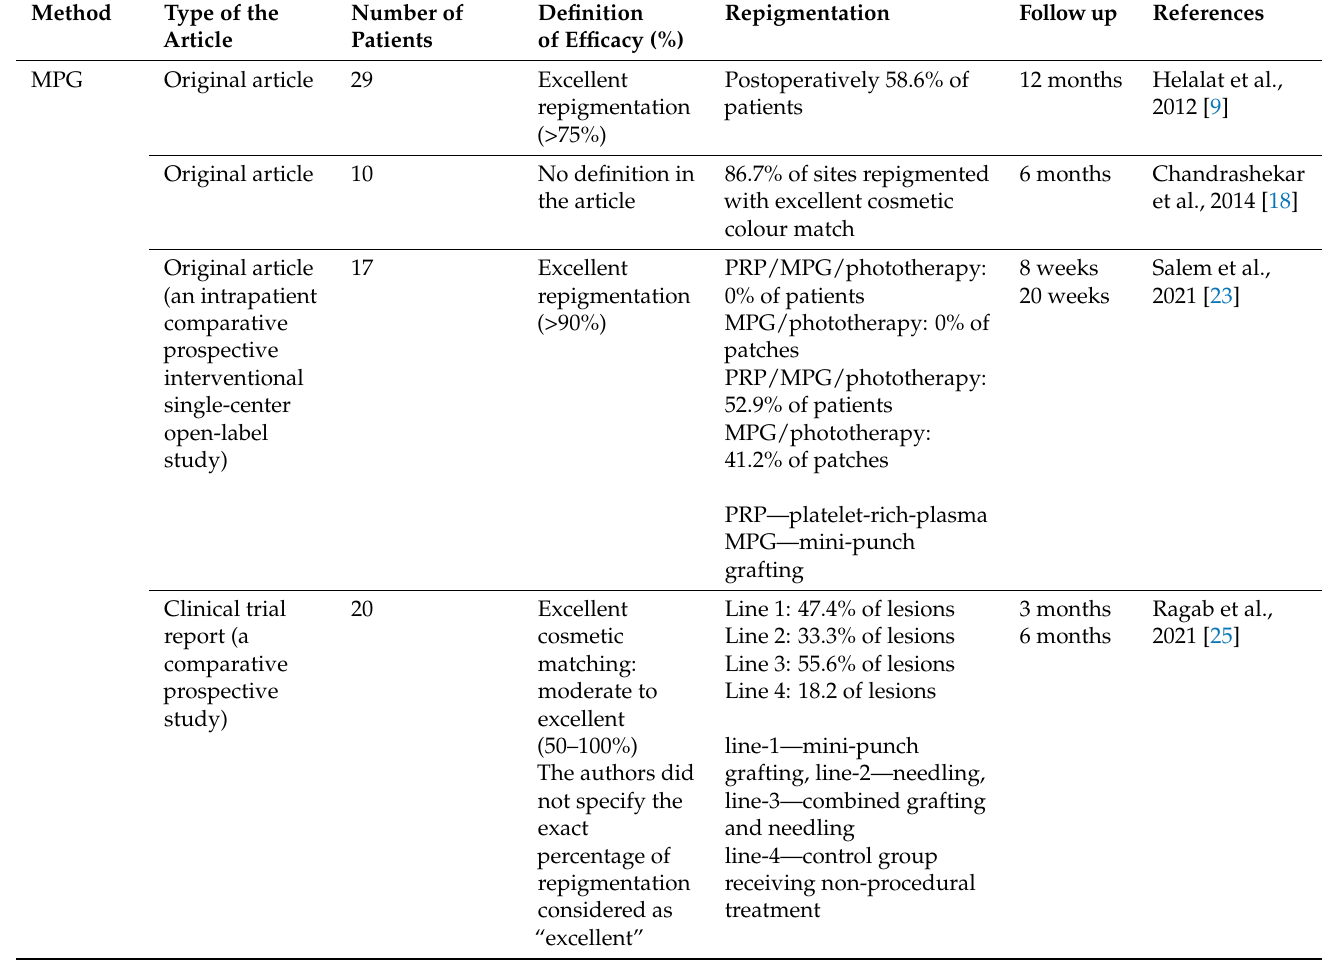
Table 3. The efficacy of available surgical